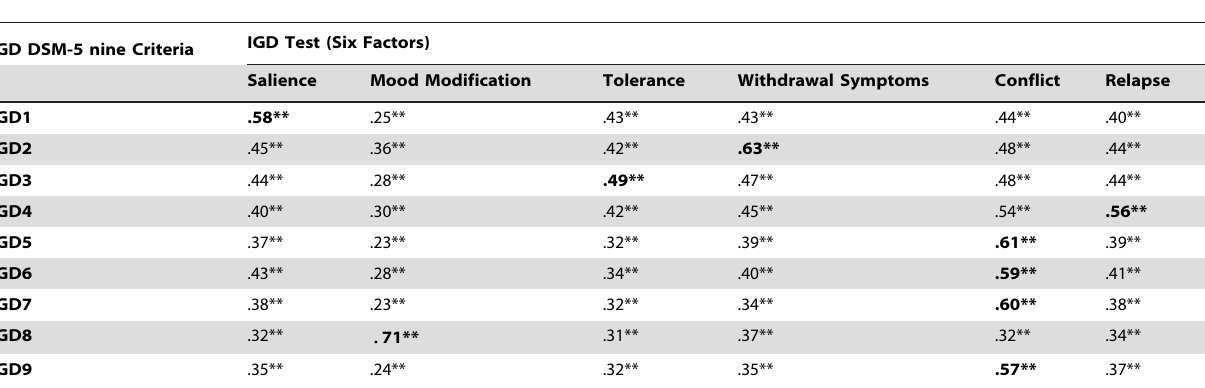
Table 5. Overall correlation between the six IGD-20 Test factors and its corresponding IGD nine criteria.